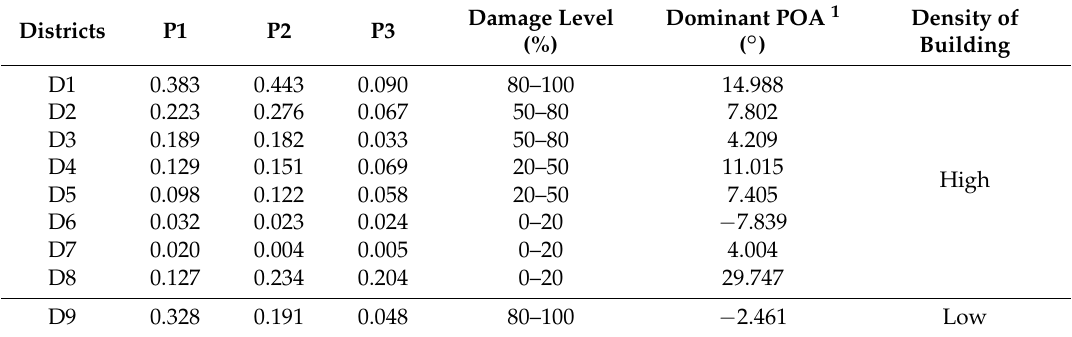
Table 3. The mean value of the index D of districts with various levels of